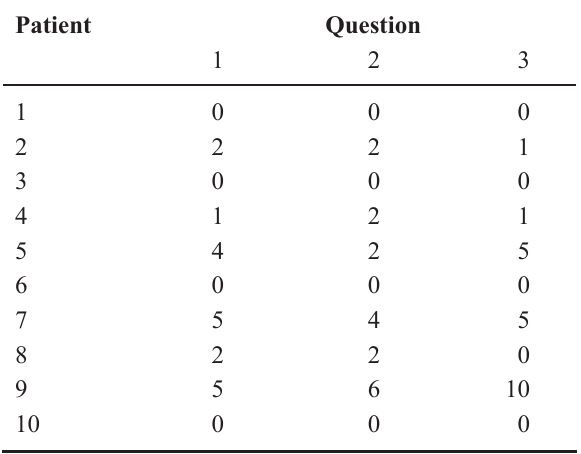
Table 2 – ICIQ patient responses.